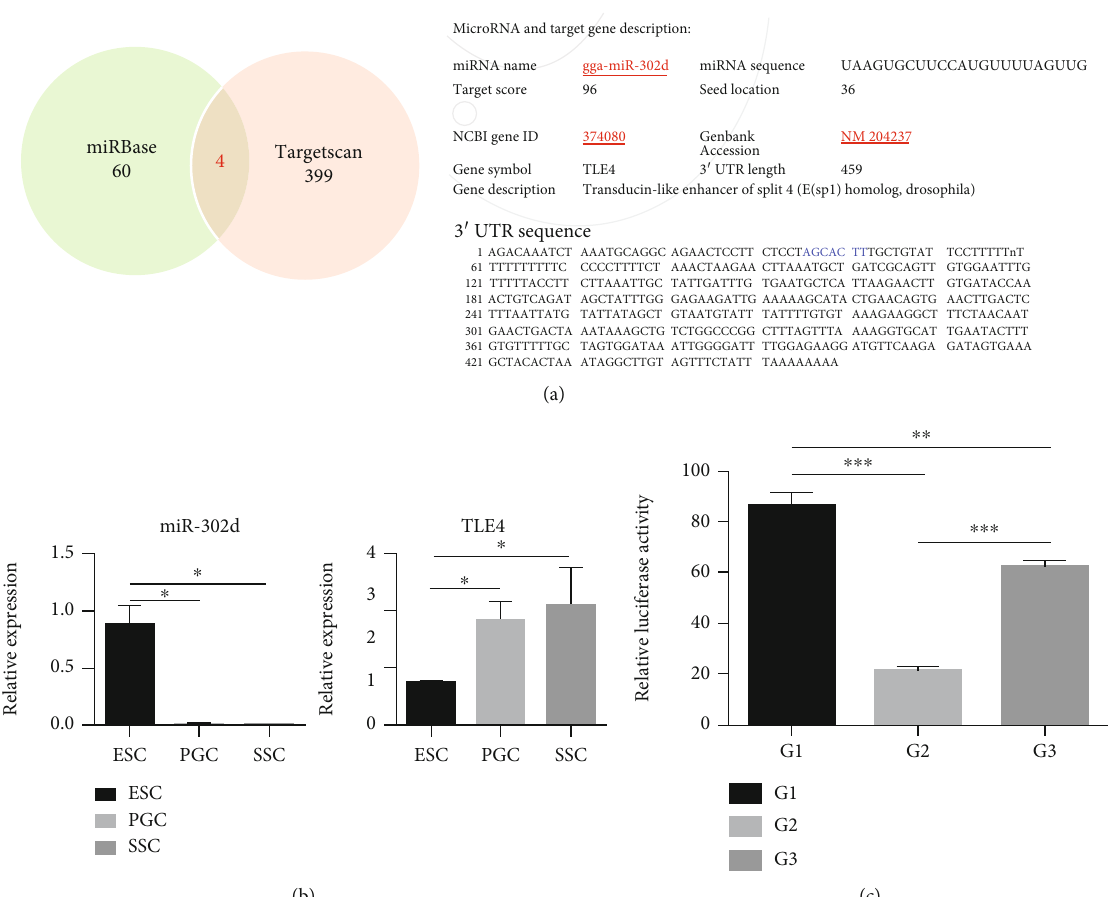
Figure 5: Screening and veri fi cation of target gene TLE4. (a) Venn diagram of biometric prediction software analysis result; detail information and 3 ′ UTR sequence of TLE4. (b) Expression level of miR-302d and TLE4 in ESCs, PGCs, and SSCs. (c) Dual-luciferase reporting assay; G1: pmiR-tle4-wt group (use TLE4 3 ′ UTR wild-type pmiR-REPORT vector to transfect DF-1 cells), G2: pmiR-tle4- wt+miR-302d mimics group (use TLE4 3 ′ UTR wild-type pmiR-REPORT vector and miR-302d mimics to transfect DF-1 cells), G3: pmiR- tle4-mt+miR-302d mimics group (use TLE4 3 ′ UTR mutant-type pmiR-REPORT vector and miR-302d mimics to transfect DF-1 cells, TLE4 3 ′ UTR mutant-type vector lacks binding site: